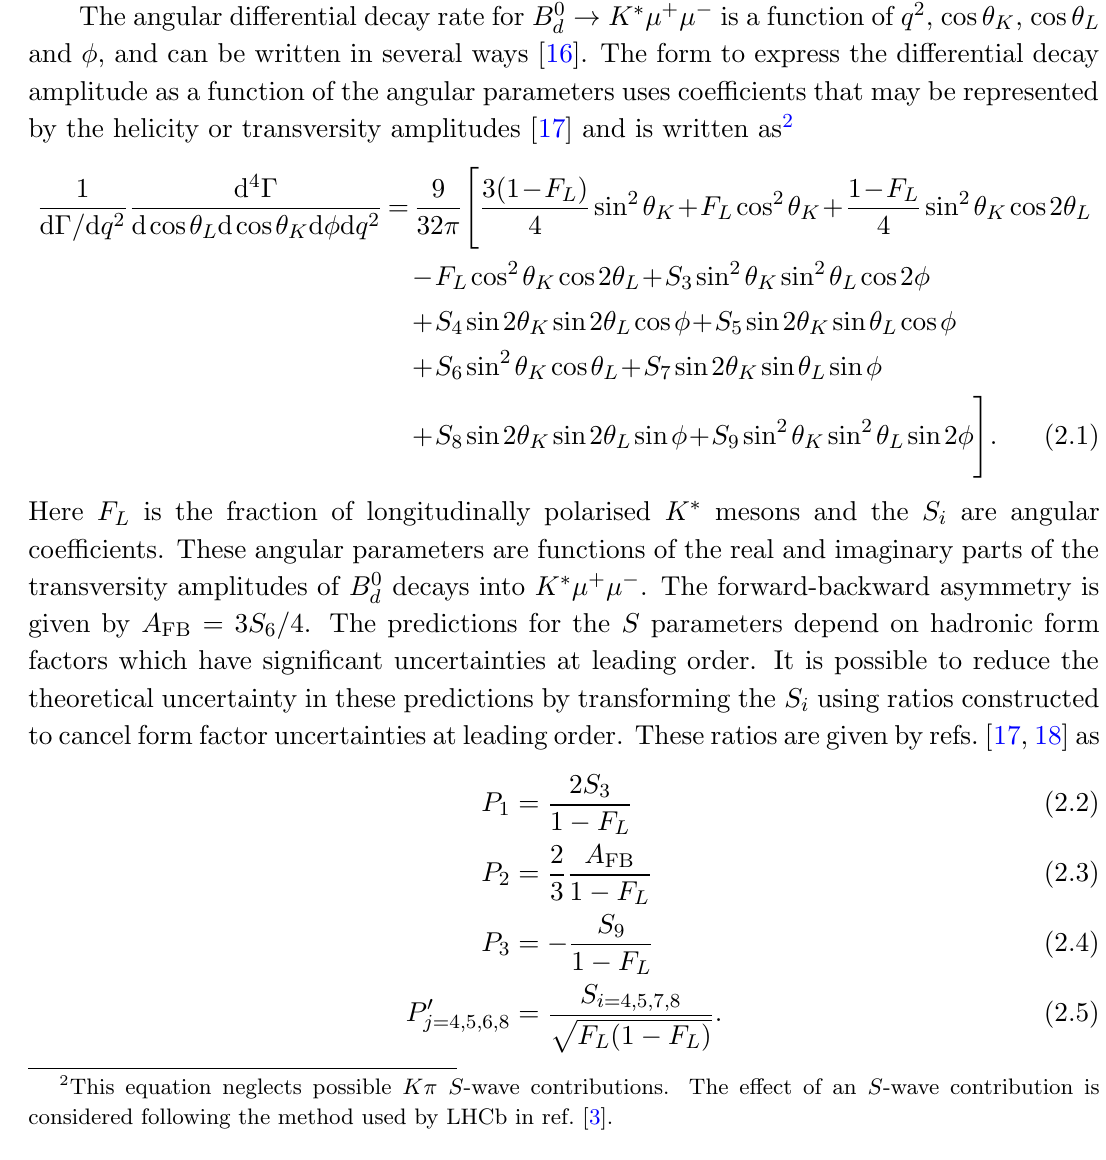
, dimuon system and B 0 (cid:3)